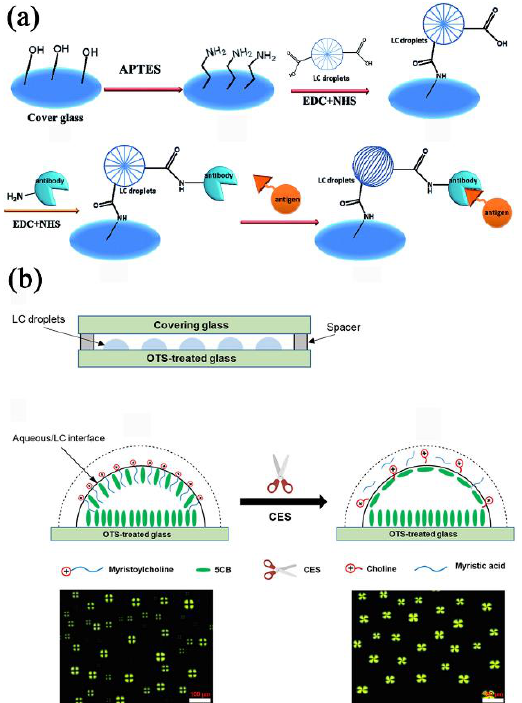
Figure 7. ( a ) Schematic illustration of slide cover glass immobilized LC microdroplets for sensitive detection of an IgG antigen. Reprinted with permission from ref. [117]. Copyright 2017 American Chemical Society. ( b ) Schematic illustration of using a LC droplet sensing platform to detect CES and its inhibitors Reprinted with permission from ref. [118]. Copyright 2022 MDPI. The scale bar is 100 µm.